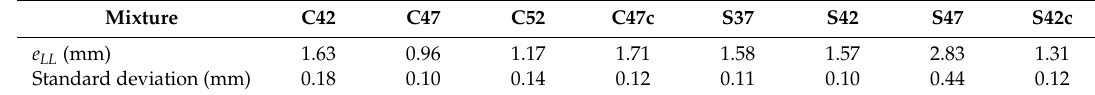
Table 4. Average analytical thickness of the lubricating layer.